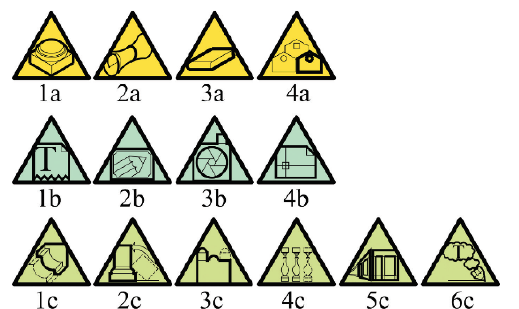
Figure 4. Deontological code to show the origin of each part of the reconstruction models. The first row indicates the type of source (physical evidence, primary source, historiographical source and typological study); the second, the type of document (text, drawing, photograph, plan), the third indicates the modality of reconstruction (by geometric continuity, virtual anastilosis, symmetry, pattern, photogrammetric restitution or free interpretation).